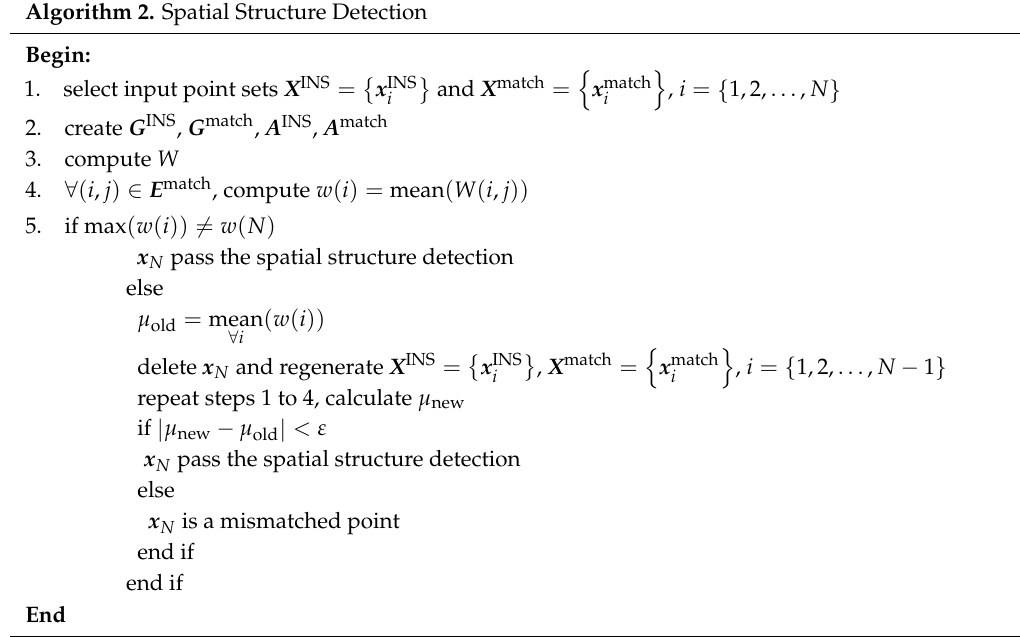
Algorithm 2. Spatial Structure